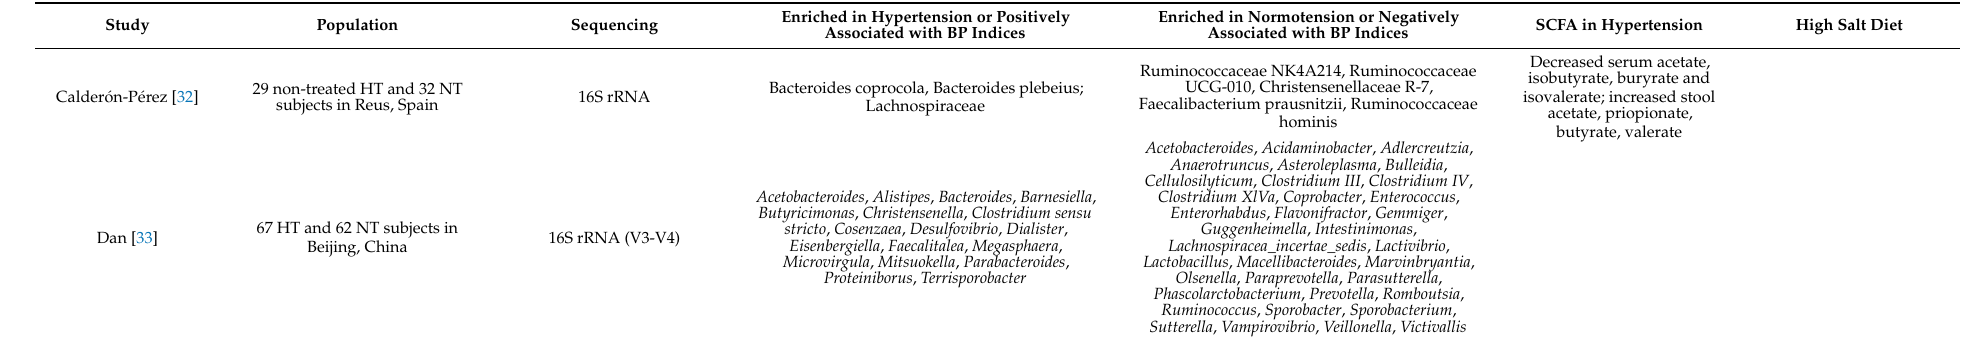
Table 2. The associations observed between human hypertension, high dietary salt, gut microbiota, and